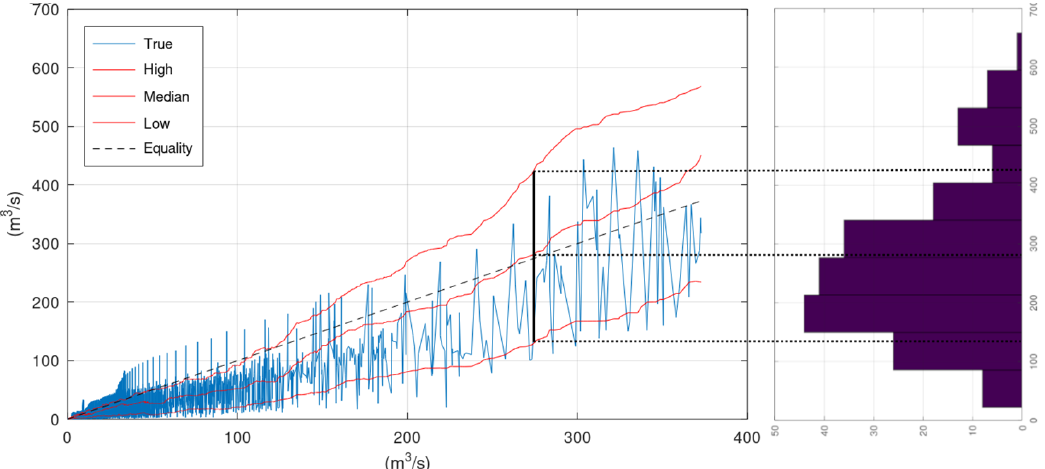
Figure 9. Visual explanation of confidence interval bound and median line for the discharge value of the hydrological simulation during the validation period equal to 275 m 3 /s (case study of Sieve River). The histogram on the right organises in classes the observed values that correspond to the 200 simulation values closer to 275 m 3 /s.